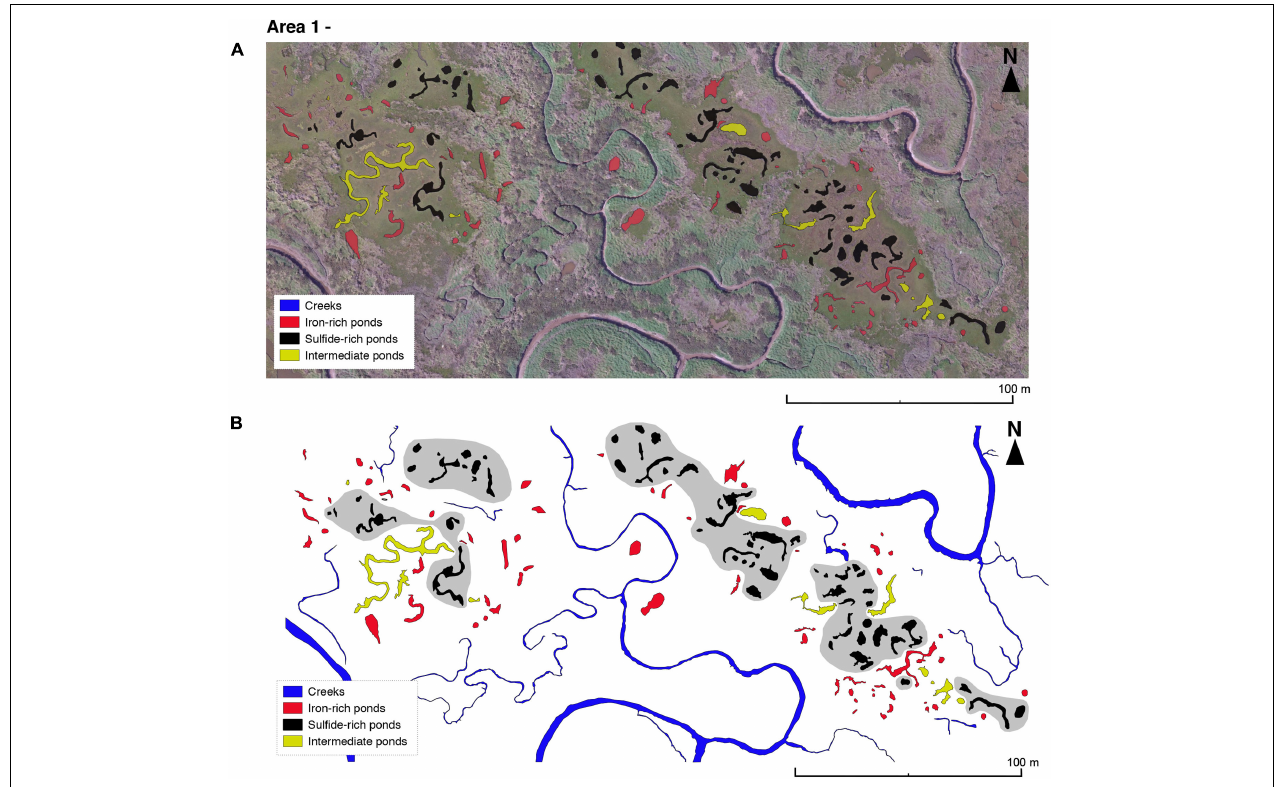
FIGURE 7 | (A) Drone imagery taken on 03/05/18 of two aggregates in Blakeney salt marsh area 1 (see Figure 1C ) overlain by geochemical classification observed over the period from May and July 2018. We changed the classification of only two ponds between May and July 2018—both were changed from sulfide-rich to intermediate. (B) Geochemical classification of ponds sediments. Hypothetical, hand-drawn zones of sulfide-rich pond clustering shown in